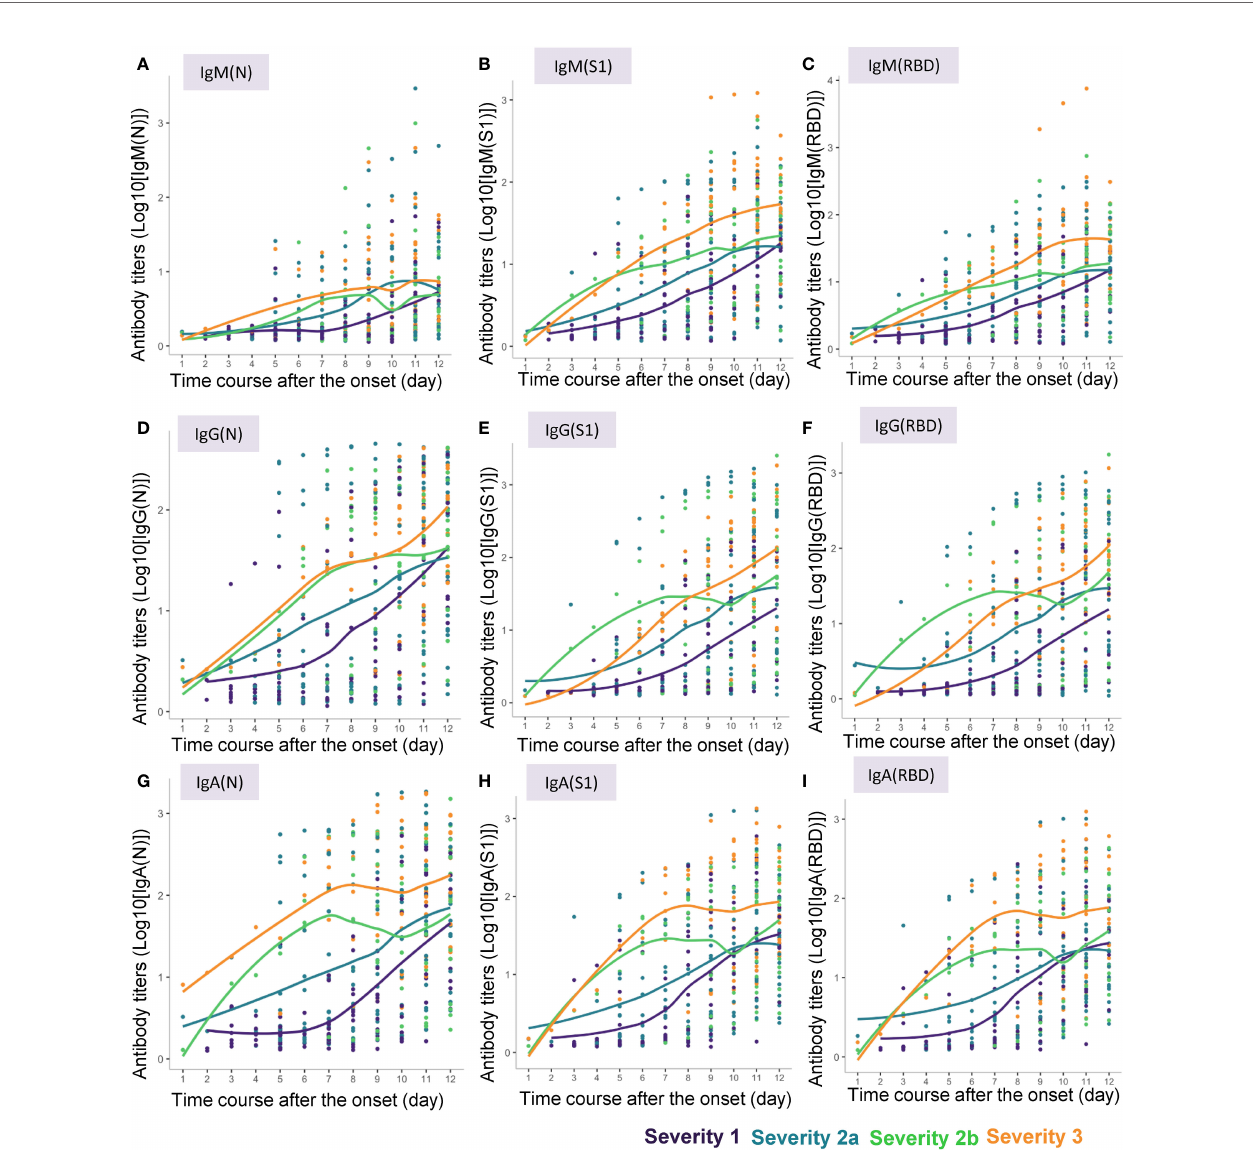
FIGURE 2 | Approximate curves for the antibody kinetics in COVID-19 patients classi fi ed by the disease maximum severity. Local polynomial regression curves were fi tted to indicate the antibody responses to the COVID-19 antigens until day 12 after symptom onset in the patients with different maximum severity levels of COVID-19. (A) IgM(N), (B) IgM(S1), (C) IgM(RBD), (D) IgG(N), (E) IgG(S1), (F) IgG(RBD), (G) IgA(N), (H) IgA(S1), (I)